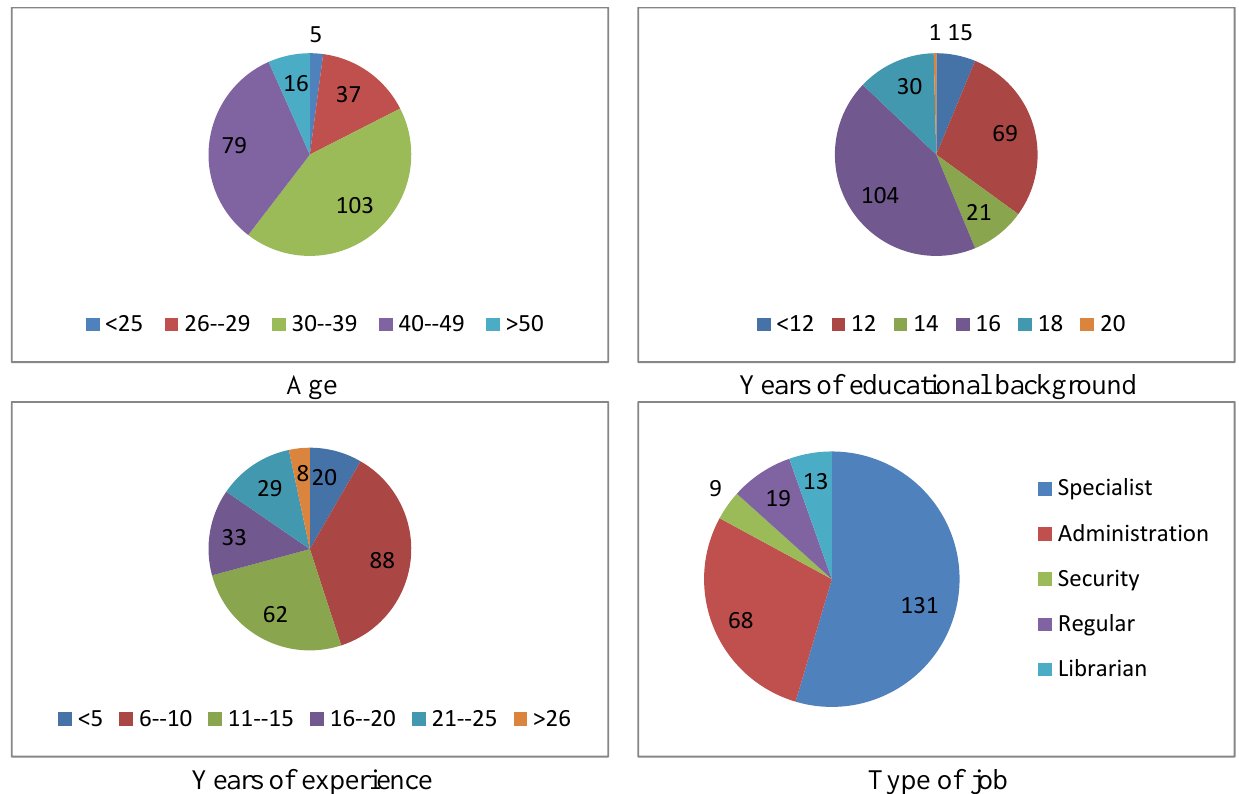
Fig. 1. Personal characteristics of the